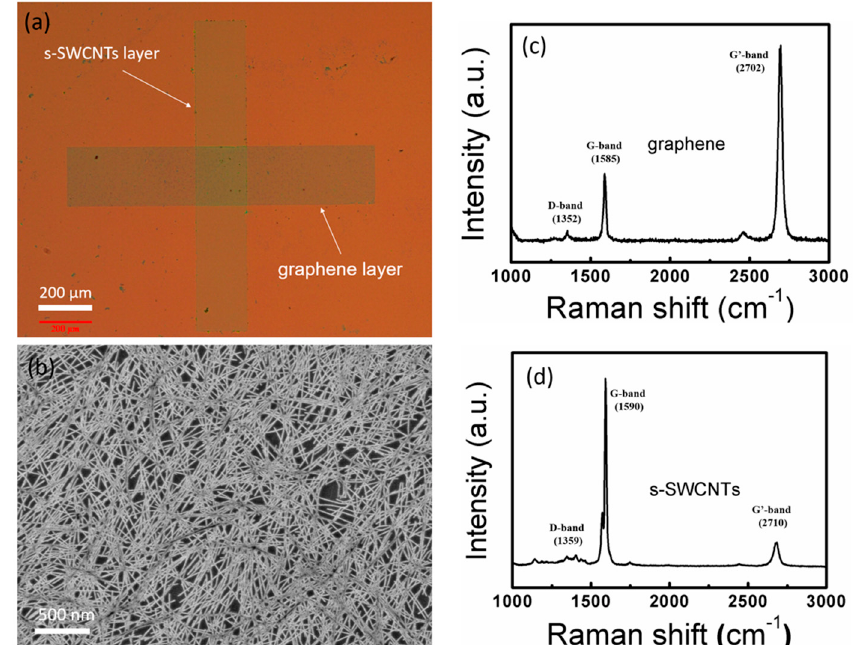
Figure 1. ( a ) The optical image of the graphene/semiconducting single-wall carbon nanotube (graphene/s-SWCNT) cross-shaped films. ( b ) The SEM image of the as-deposited s-SWCNT film ( c ) The Raman spectrum in G-band regions for the chemical vapor deposition (CVD)-grown graphene after it was transferred on the top of s-SWCNT film. ( d ) The Raman spectrum in G-band regions for as-deposited s-SWCNT film.